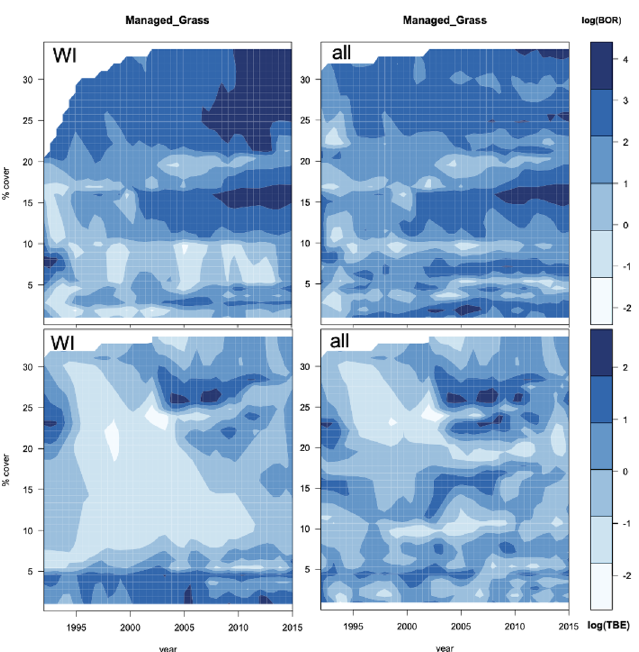
Figure 8. Interpolations for the log of incidence of BOR (top) and TBE (bottom) with respect to the percentage cover of yearly evolution of managed grass for ( left ) the WI districts and ( right ) all districts.